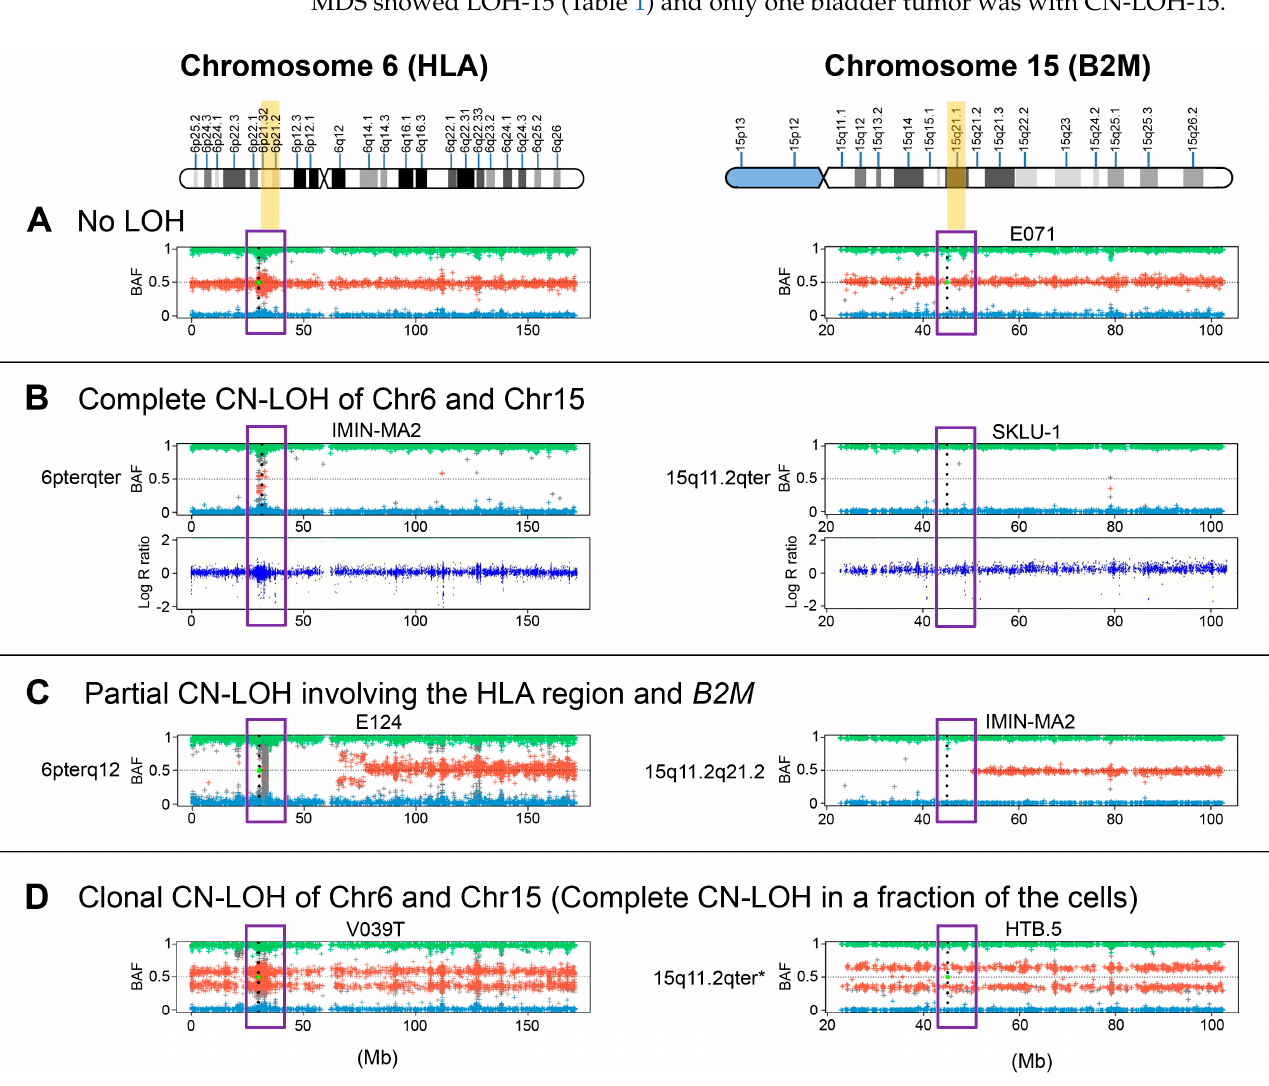
Figure 3. Examples of different CN-LOH patterns at chromosomes 6 (left panel) and 15 (right panel), involving HLA and B2M genomic regions, respectively, in human tumor cell lines and in microdissected bladder tumors. ( A ) Examples of cell lines without LOH; ( B ) Cell lines with a complete loss of a chromosome 6 and 15 (CN-LOH); ( C ) Partial CN-LOH involving HLA and B2M genes; ( D ) Complete CN-LOH in a fraction of cells, clonal CN-LOH (*).